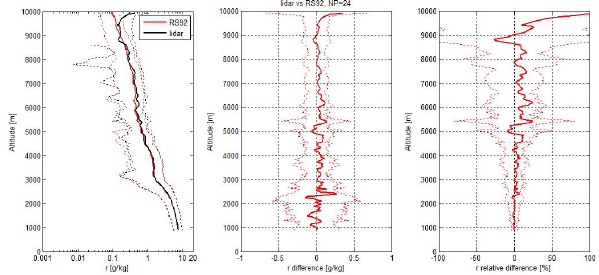
Fig. 5. (Left) comparison of campaign-mean WVMR measured by IGN-LATMOS Raman lidar and Vaisala RS92 (24 profiles); (mid- dle) mean difference Lidar – RS92 (gkg − 1 ); (right) mean relative difference (lidar – RS92)/(lidar + RS92)*200 (%). The dotted lines show ± 1 standard deviation around the mean profiles in Left plot, and around zero in the two other plots.